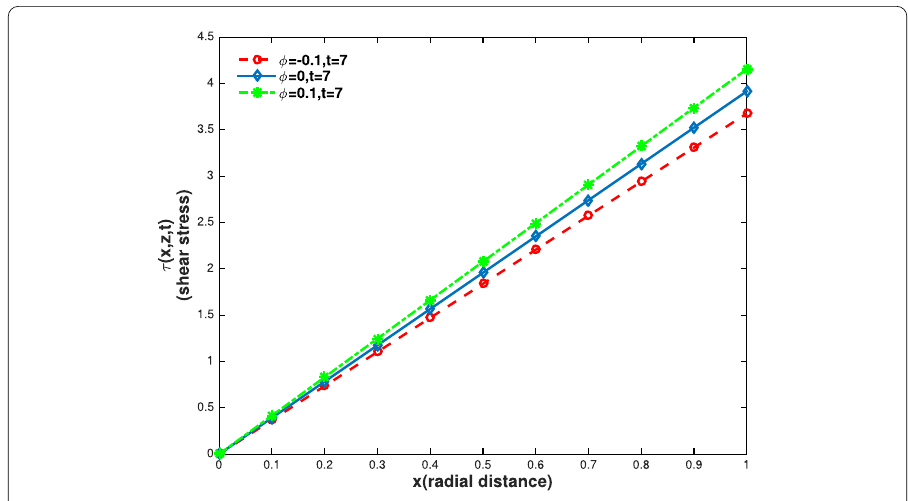
Figure 5 Shear stress vs radial distances for φ = –0.1,0,0.1 at z = 28, t = 7, τ y = 0.4, K = 1.6